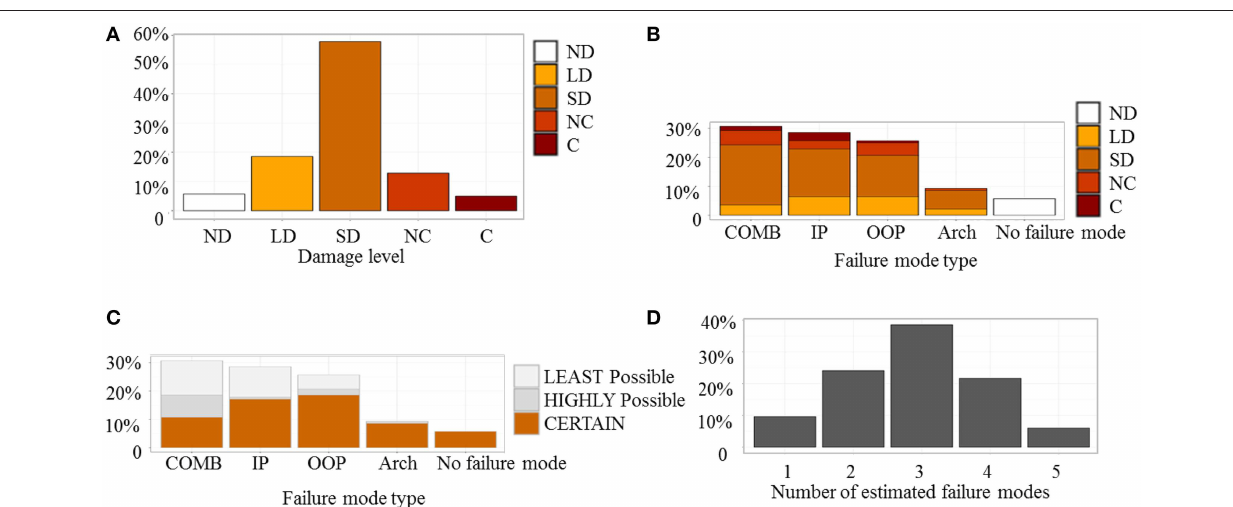
FIGURE 12 | (A) Occurrence in percentage of the damage level observed where C: Collapse ; NC: Near Collapse ; SD: Significant Damage ; LD: Light Damage and ND: No Damage ; (B) occurrence in percentage of the number of failure modes observed for façade classified with reference to their damage levels; (C) occurrence in percentage of the type of CERTAIN/POSSIBLE events observed for façade and (D) occurrence in percentage of the number of failure modes observed per